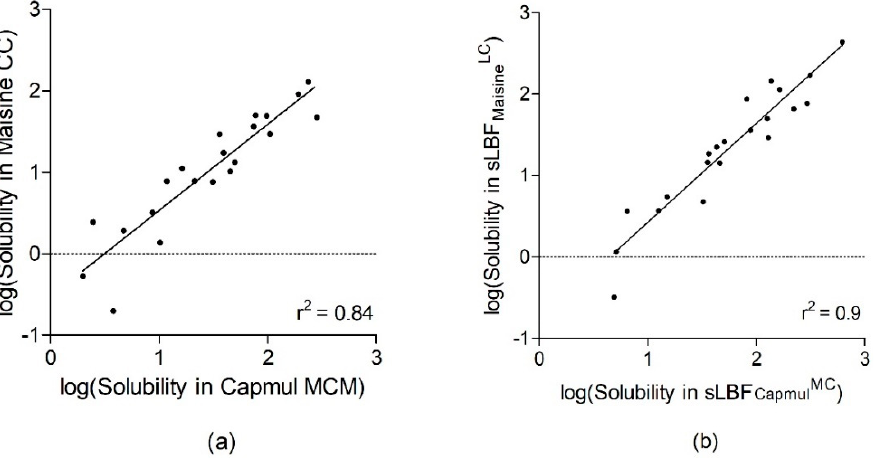
Figure 1. Scatter plots of the solubility in Capmul MCM versus Maisine CC ( a ) and sLBF CapmulMC versus sLBF MaisineLC ( b ). Formulation abbreviations can be inferred from the main text.